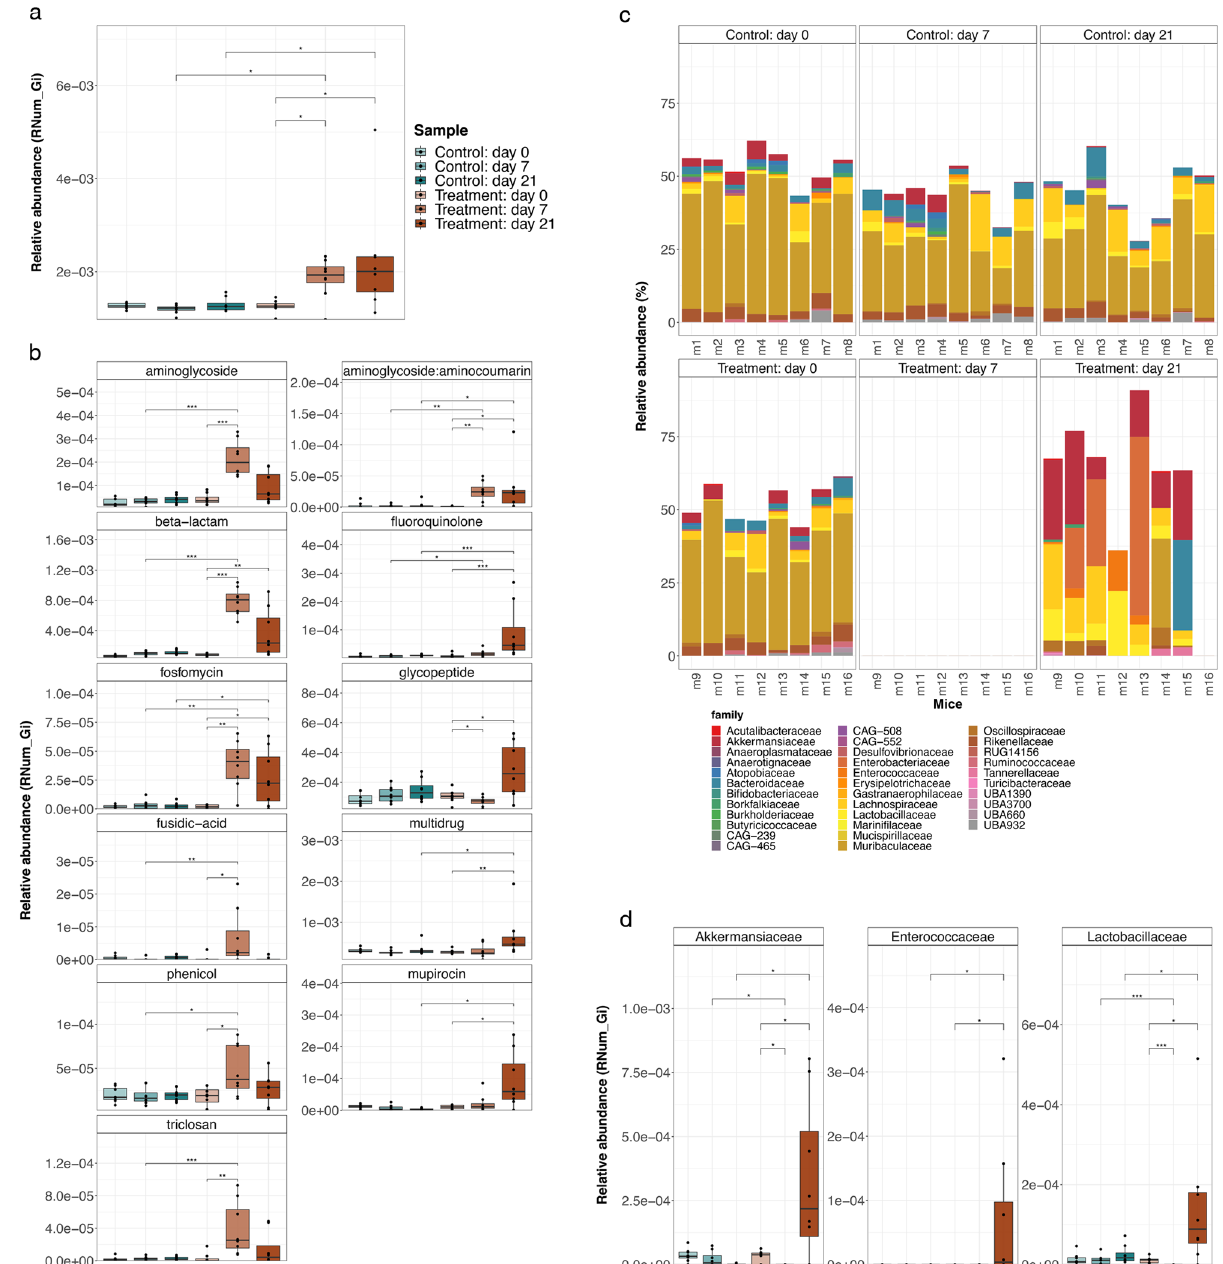
Fig. 2 Resistome in antibiotic-treated mice. a Overall ARG relative abundance levels are shown for each group ( n = 8 biological replicates). *represents signi fi cance with an adjusted p -value less than 0.05 as assessed using a Wilcoxon rank-sum test. The center line denotes the median value (50th percentile), while the outer lines of the box represent the 25th to 75th percentiles. The black whiskers mark the 5th and 95th percentiles. b Signi fi cantly differentially abundant AMR categories found to be enriched in the mice treated with antibiotics compared across different timepoints, i.e., day 0, day 7, and day 21, *adjusted p -value < 0.05 (Wilcoxon rank-sum test). n = 8, biological replicates per group. The center line denotes the median value (50th percentile), while the outer lines of the box represent the 25th – 75th percentiles. The black whiskers mark the 5th and 95th percentiles. c Barplots showing the relative abundance of MAGs (Family level) associated with ARGs in each sample. d Relative abundance of ARGs associated with Akkermansiaceae, Enterococcaceae, and Lactobacillaceae in the control and treated mice ( n = 8 biological replicates per group). *adjusted p -value < 0.05 (Wilcoxon rank- sum test). The center line denotes the median value (50th percentile), while the outer lines of the box represent the 25th – 75th percentiles. The black whiskers mark the 5th and 95th percentiles. Signi fi cance for all analyses was assessed using a two-sided Wilcoxon rank sum test, where, p -values are indicated by *, i.e., * < 0.05, ** < 0.01, *** < 0.001. Source data are provided as a Source Data fi